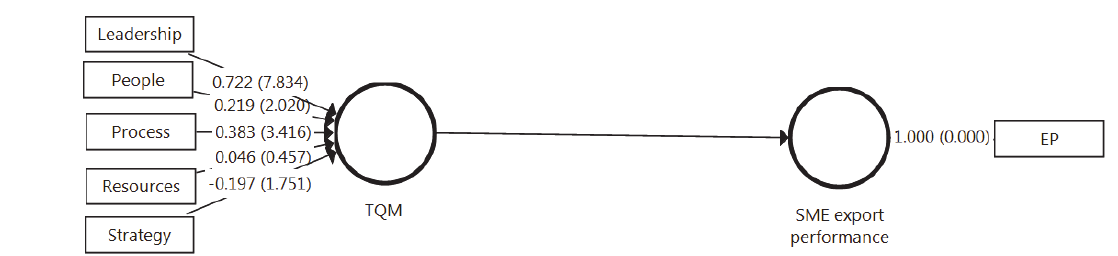
Fig. 3. Measurement model -2 nd order (formative) two-stage approach (outer weights / T-value) Findings of Measurement Model for Formative constructs Constructs Indicator Outer loading OL Outer OW VIF Total Quality Management